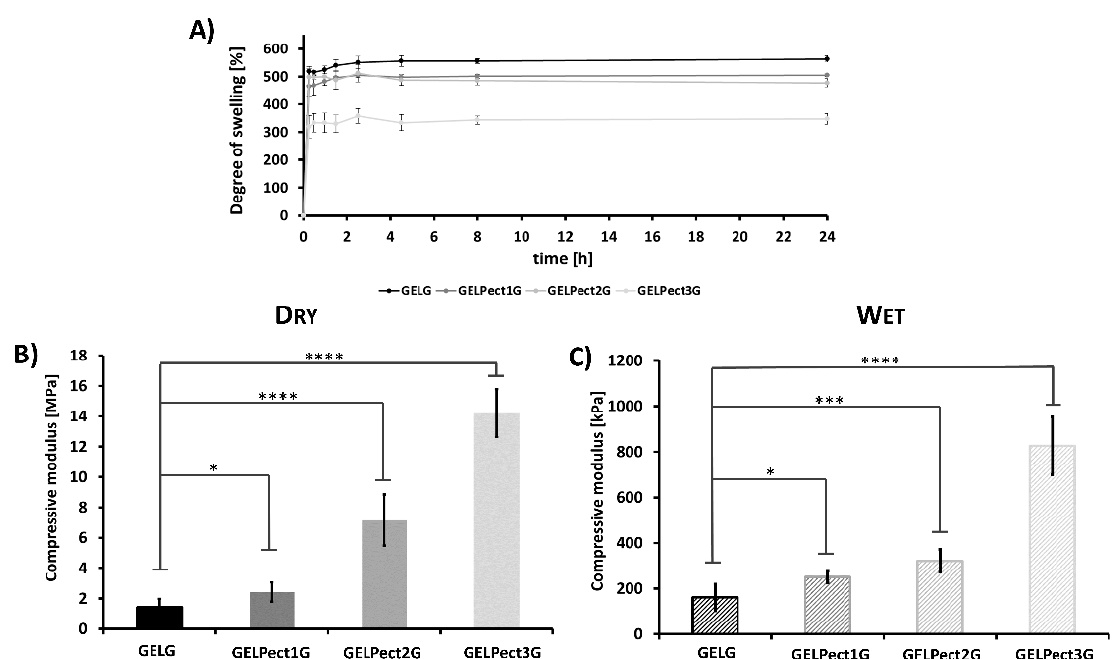
Figure 3. Degree of swelling over time of GEL, GELPect1, GELPect2, and GELPect3 sponges ( A ). Compressive modulus of dry ( B ) and wet ( C ) GELG, GELPect1G, GELPect2G, and GELPect3G sponges. (Student’s t-test significance levels * = p < 0.05, *** = p < 0.0005, **** = p < 0.0001, comparing the compressive modulus of GELG (control) and other GELPectG sponges).